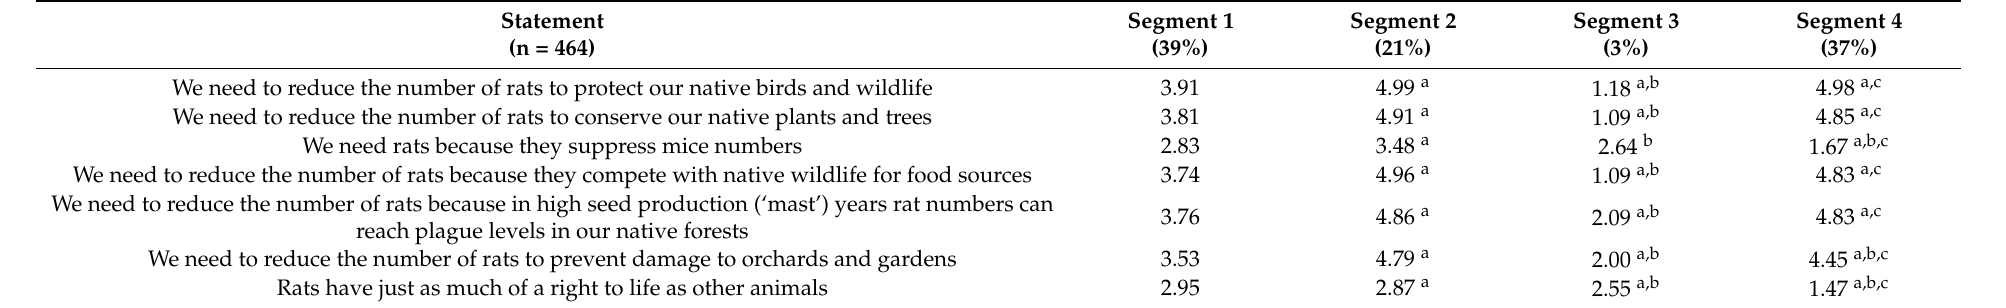
Table 1. Belief segments for reducing rat numbers.